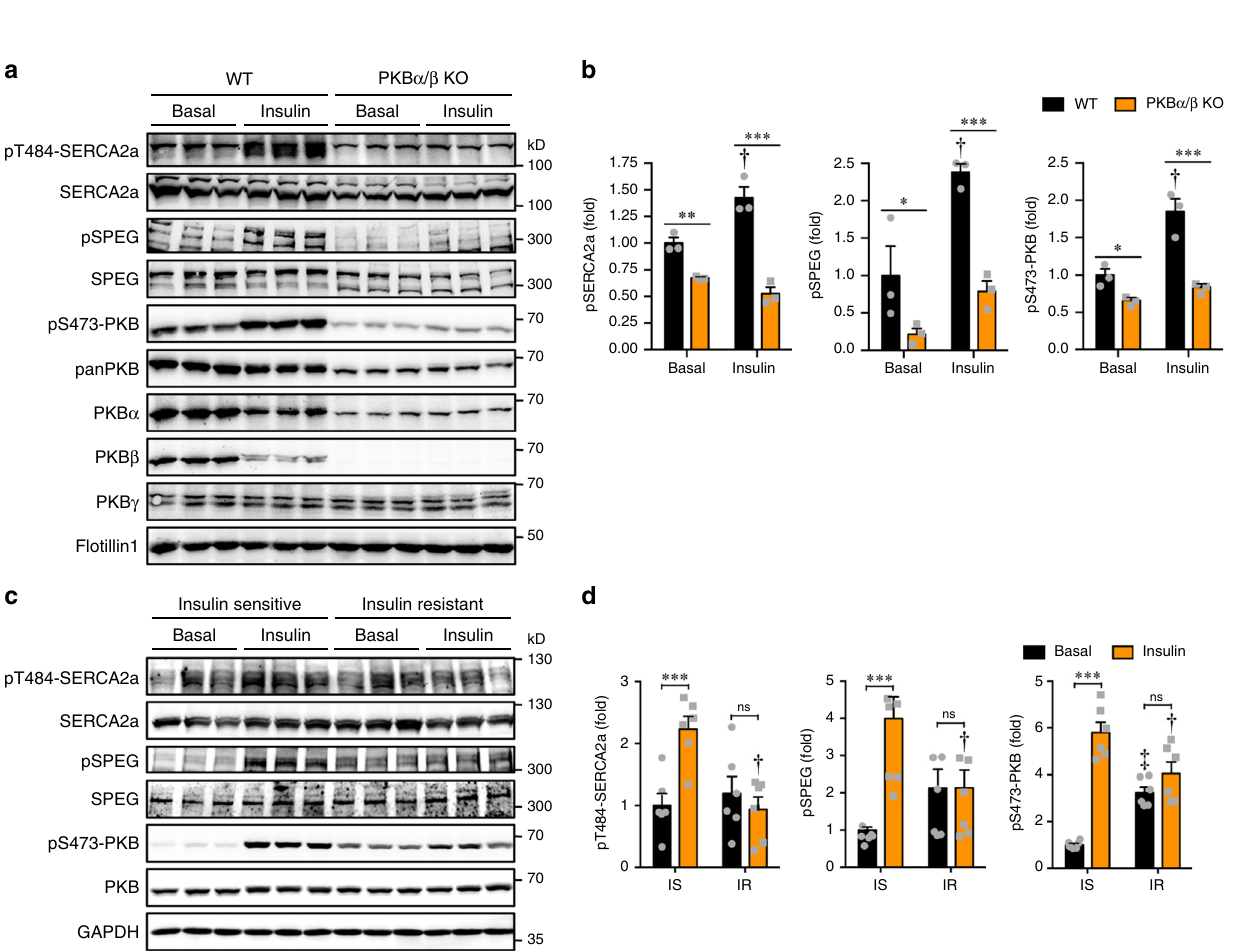
Fig. 4 Effects of PKB-mediated phosphorylation of SPEG on the activity of its second kinase-domain. a , b Flag-SERCA2a was co-expressed with GFP- SPEG WT or mutant proteins in HEK293 cells. After immunoprecipitation, phosphorylation of Flag-SERCA2a was detected using the pSer/Thr antibody. a representative blots. b Quantitation of SERCA2a phosphorylation. n = 8 (GFP and SPEG 3A ) and 7 (SPEG and SPEG D3098A ). c , d Flag-SERCA2a was co- expressed with GFP-SPEG WT or mutant proteins in HEK293 cells. Oligomerization of SERCA2a was determined via western blot and subsequently quanti fi ed. Representative blots were shown in c and quantitative data shown in d . n = 6. E-F. CFP-SERCA2a and YFP-SERCA2a were co-expressed with HA-SPEG WT or mutant proteins in HEK293 cells. Inter-molecular interaction of SERCA2a was measured via FRET. E, quantitative data on FRET ef fi ciency. f representative images for FRET. n = 28 (vector), 30 (SPEG), 35 (SPEG D3098A ), and 29 (SPEG 3A ). Bars indicate 5 μ m in length. g , h HA-SERCA2a was co- expressed with Flag-SERCA2a in the presence of GFP-SPEG WT and mutant proteins in HEK293 cells. Flag-SERCA2a was immunoprecipitated, and the abundance of HA-SERCA2a in the immunoprecipitates was detected via immunoblotting. g representative blots. h Quantitative data. n = 11 (GFP), 10 (SPEG), and 9 (SPEG D3098A and SPEG 3A ). i , j Calcium transients in HEK293 cells expressing mCherry-SERCA2a together with HA-SPEG WT or mutant proteins. Calcium transients were recorded using a confocal microscopy in cells that were stimulated with ATP. Full duration at half maximum (FDHM, i ), and time constant Tau ( j ) of calcium transients were subsequently determined. n = 68 (SERCA2a WT + SPEG WT), 43 (SERCA2a WT + SPEG D3098A ), 64 (SPEG + SERCA2a T484A ), and 20 (SERCA2a WT + SPEG 3A ). k Calcium transients in neonatal rat cardiomyocytes expressing vector, mCherry-SPEG WT or mCherry-SPEG 3A mutant proteins upon fi eld stimulation. Amplitudes, FDHM and Tau of calcium transients were quanti fi ed from 30 (vector), 12